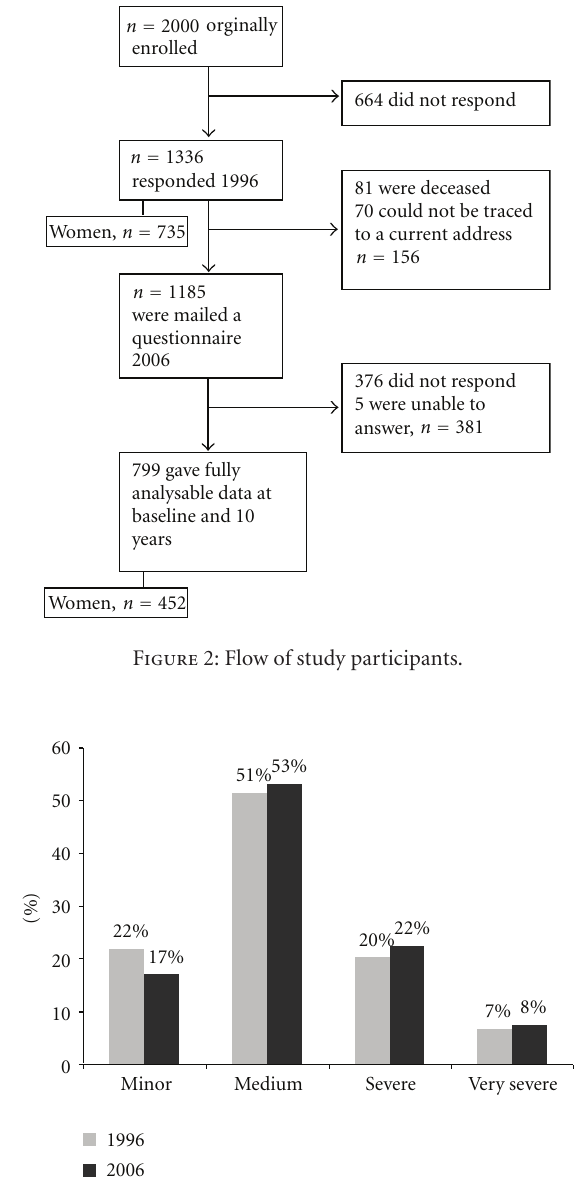
Figure 3: Distribution of dysmenorrhea severity (1996, n = 254, 2006, n = 152).